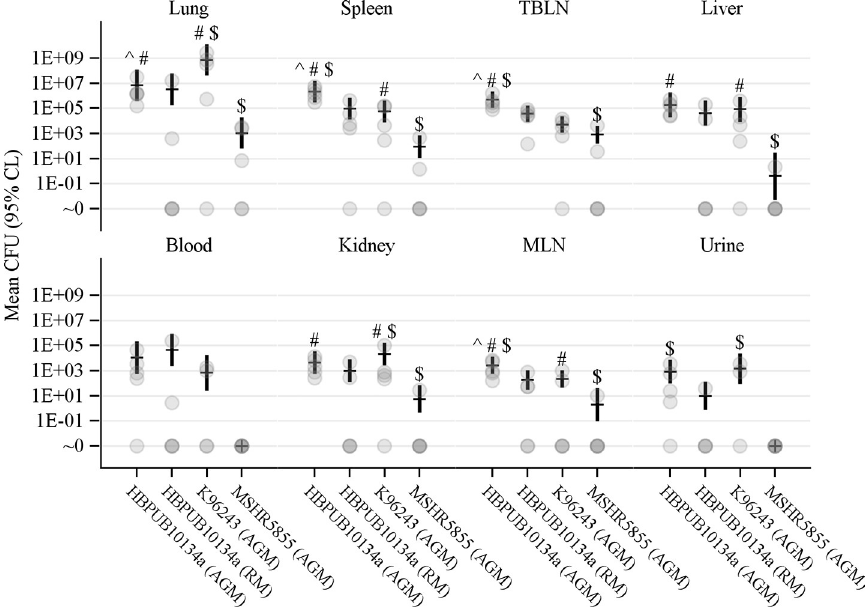
Fig 9. Organ burdens of NHPs aerosolized with B . pseudomallei . Estimates of the mean CFU count per gram tissue (organs), or per mL (blood and urine) obtained by negative binomial regression, are shown as a dash, with error bars showing the 95% CL. Gray circles indicate the values obtained for each animal. Symbols indicate p < 0.05 by an approximate t -test: ^ vs AGM/K96243, # vs AGM/MSHR5855, $ vs